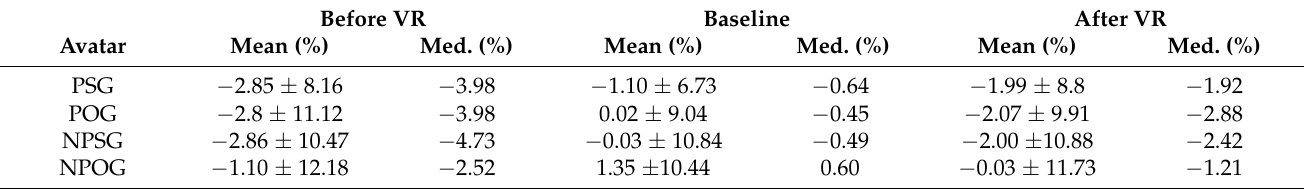
Table 4. Difference of the mean heart rate of each avatar and the different segments of the study. The average heart rate of the segment was used as the base